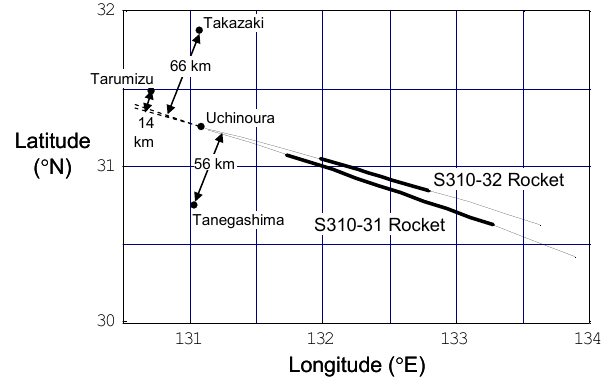
Figure 1. Map of the trajectories of the SEEK2 rockets relative to the four radio beacon Fig. 1. Map of the trajectories of the SEEK-2 rockets relative to the sites on the ground. four radio beacon sites on the The locations of the receivers and a projection of the rocket trajectories are shown by the map in Figure 1 and the side view of Figure 2. The two rockets were launched from Uchinoura on Kyushu, Japan. The S310-31 rocket was launched on 3 August 2002 at 23:24 JST (14:24 GMT) and S310-32 was launched precisely 15 minutes later. The trajectories carried the rockets into the Pacific Ocean for a non-recoverable splash down. The two sites at Takazaki and Tanegashima were located 66 and 56 km, respectively, on either side of the planes defined by the rocket trajectories. The site at Tarumizu was located to be near the plane of the trajectory so that tomographic imaging could be attempted in that plane. The dashed lines in Figure 1 are a backward extension of the lines of the trajectories. The Tarumizu site is 14 km to the south-west of the trajectory plane for the SEEK2 rockets. The dark portions of the trajectories in both Figures 1 and 2 illustrate the portion above 105 km altitude. During this portion, the radio beacon transmitting signals through the E- region. The apogees of the S310-31 and S-310-32 rockets were 151.88 and 116.63 km, respectively. The rockets apogee was kept low enough to keep the rocket from entering the overlying F-region. The paths to three of the receivers from a point on the trajectory show that the slant TEC in the E region is measured at multiple points at each time in the rocket flight. Both in situ measurements and ground ionosonde records indicate that all of the plasma below 152 km altitude was confined to a 10 km region around 105 km altitude. This permits the radio beacon data to be analyzed using the thin-layer computerized tomography described later.